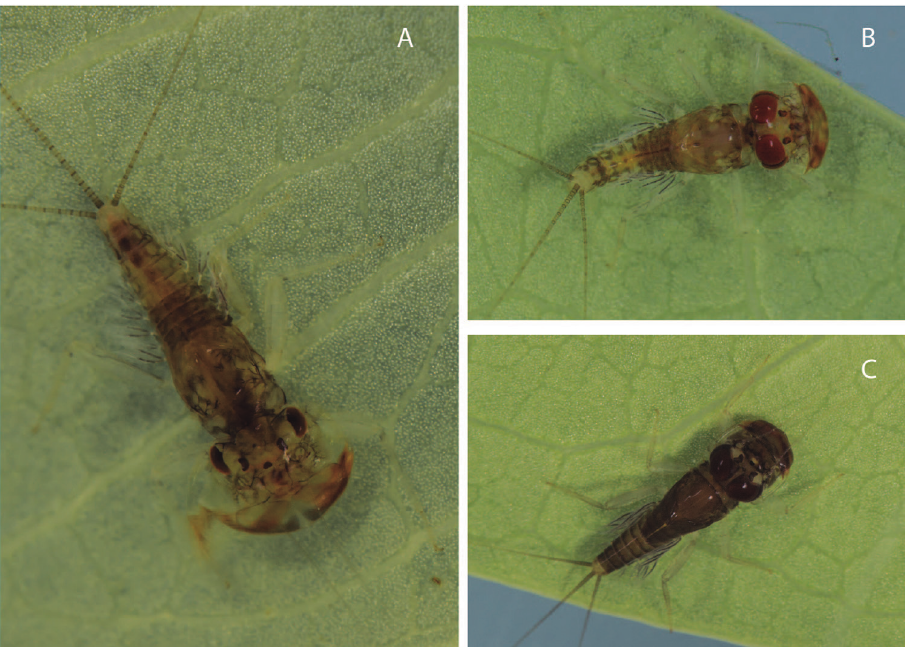
Figure 7. Living specimens: a Hydromastodon sallesi , female nymph b Hydromastodon sallesi , male nymph c Leentvaaria palpalis , male